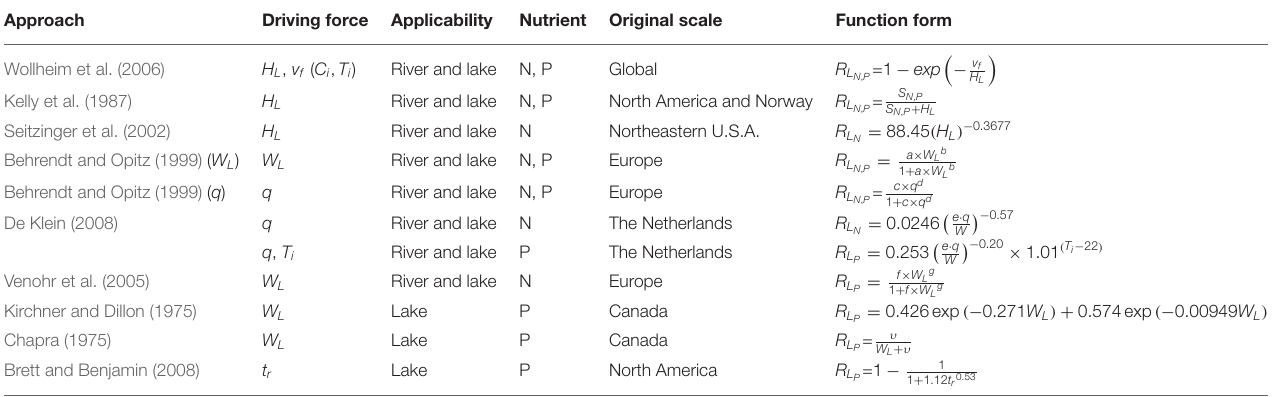
TABLE 1 | Summary of retention models proposed by previous